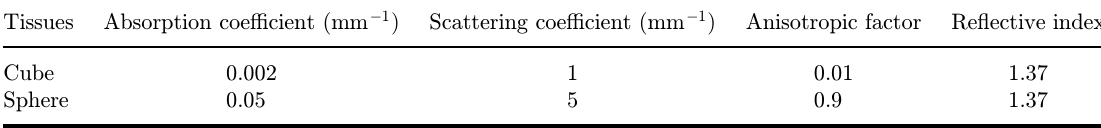
Table 3. Optical properties of the regular-shaped phantom